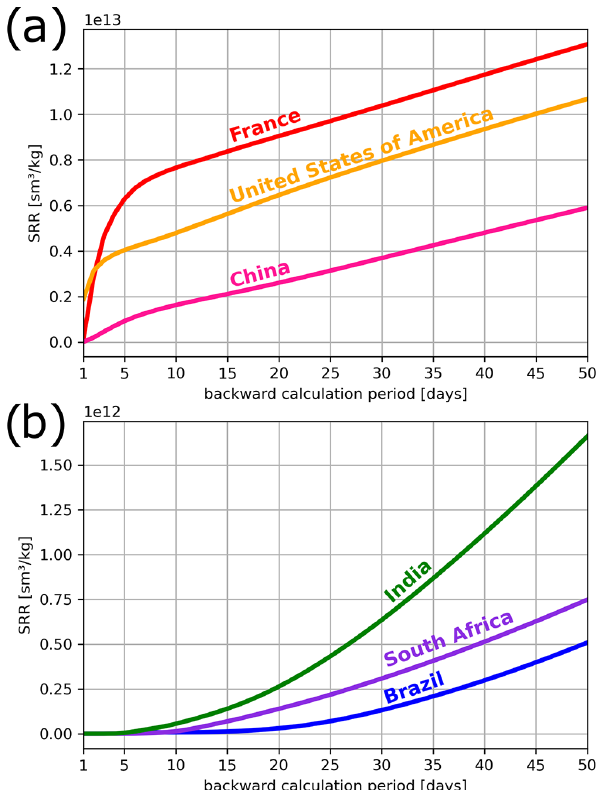
Figure 11. SRR for individual countries and different backward cal- culation periods between 1 to 50d, considering all continuous mea- surement stations in Table 1. The values shown are averages over the grid cells of (a) France, USA, and China and (b) India, South Africa, and Brazil for the year 2012.